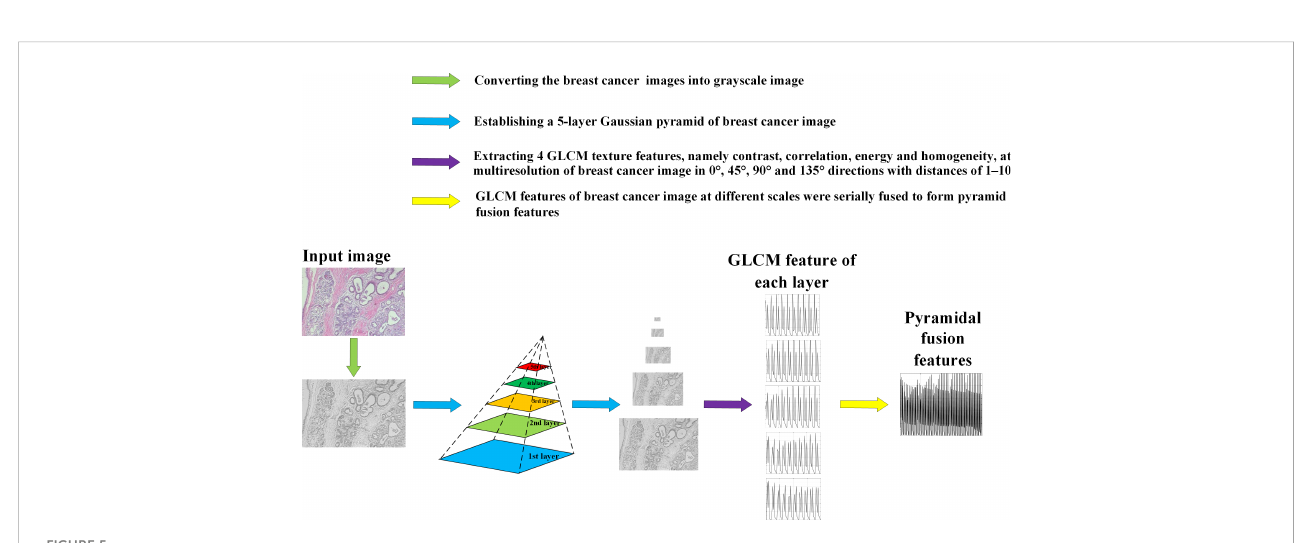
FIGURE 5 Feature extraction process of breast cancer histopathological images based on